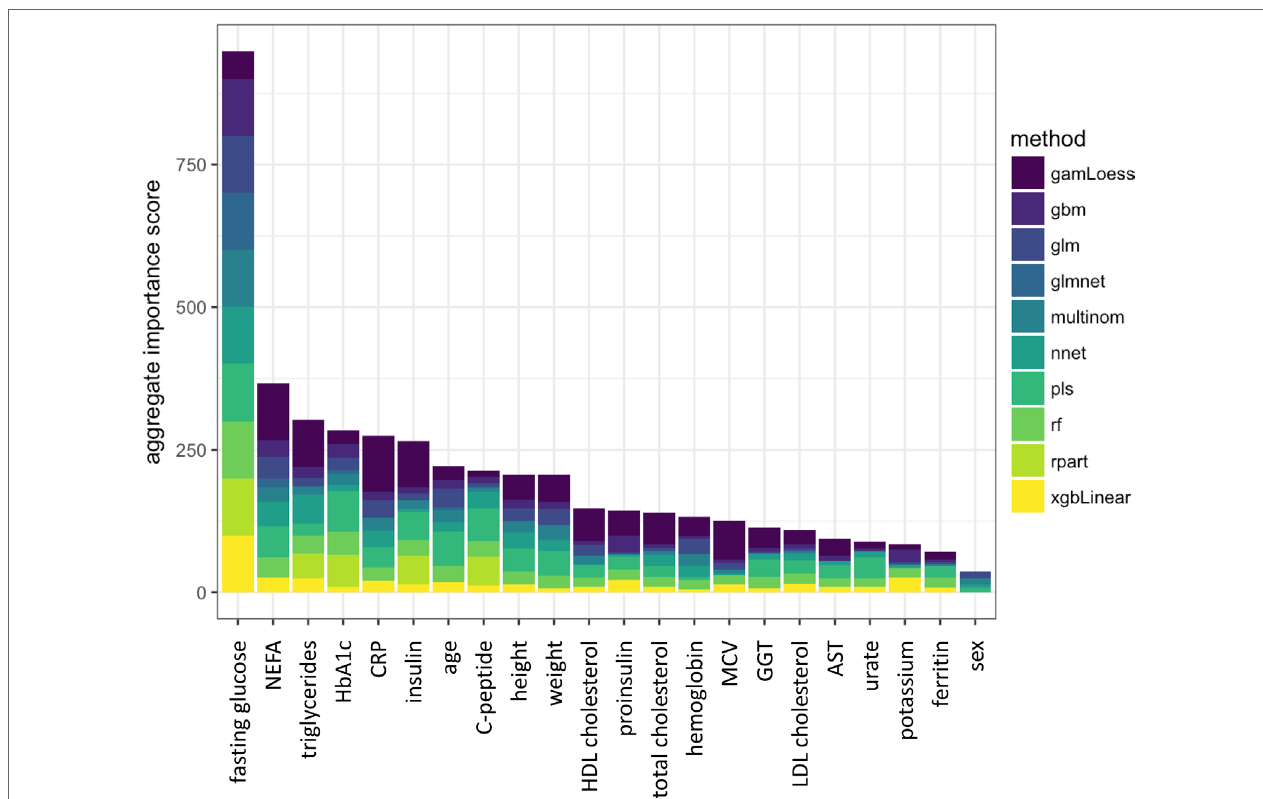
FigUre 1 | Aggregated importance score in the machine learning classifiers for each feature variable. Individual importance scores are represented by colors in the stacked bars. The classifiers are described in Table S1 in Supplementary Material.